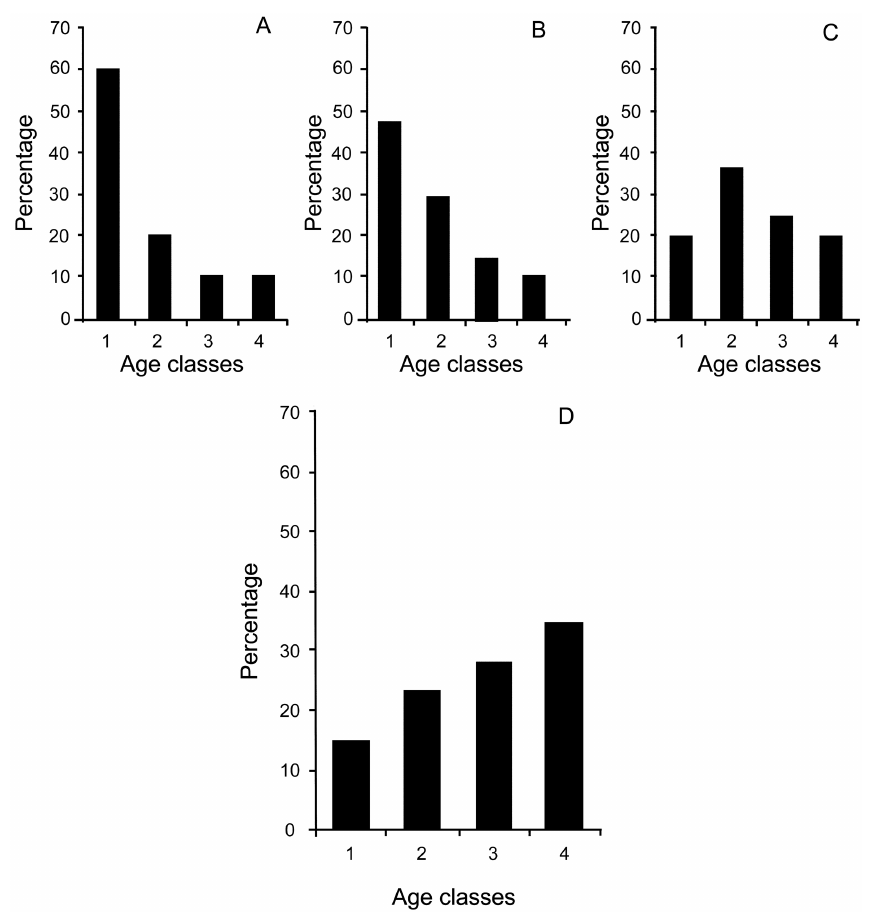
Fig. 6 – Age profiles of populations with different demographic status: A) Expanding; B) Stable; C) Declining (all three modified from Haynes, 1991); D) Profile of the Stegomastodon waringi population from Águas de Araxá, Minas Gerais, Brazil. Age Classes: 1) 0-12 yrs; 2) 13-24 yrs; 3) 25-36 yrs and 4) 37-60